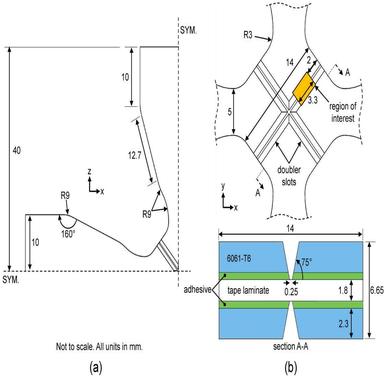
Cruciform specimen geometry showing (a) the external dimensions of the specimen and (b) the details and dimensions of the gage region. The orange box in the top right image represents the ROI that was imaged at each loading interval. (For interpretation of the references to color in this figure legend, the reader is referred to the Web version of this article.)